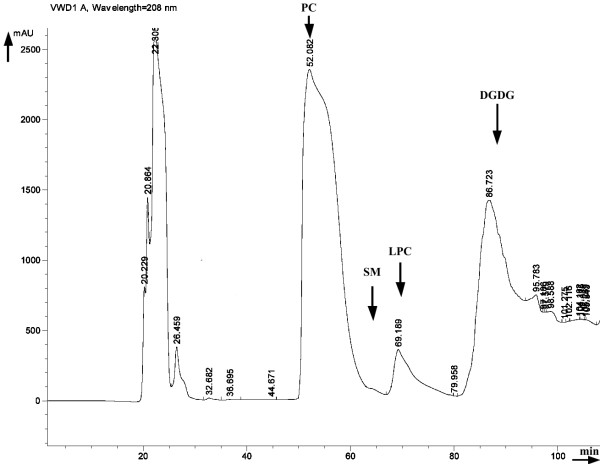
Representative HPLC chromatograph of GSBPL. Mobile phase was composed of solvent A; acetonitrile/methanol (60:40 v/v), solvent B; methanol (100%) and solvent C; water (100%). The mobile phase flow rate was adjusted to 1.0 mL/min, and UV detection wavelength was set at 208 nm. After 55 min holding of 100% solvent A, a linear ramp up to 100% B over 5 min was developed, followed by a 10 min holding of 100% B, then a linear ramp up to 100% C over 5 min was followed by a 30 min holding of 100% C. A 35 min equilibration was performed before the next analysis. Elution times of standard polar lipids were the following: phospahtidylcholine (PC) at 50-60 min, sphingomyelin (SM) at 62-67 min, lysophospahtidylcholine (LPC) at 68-80 min and digalactosyldiglycerides DGDG at 81-94 min.